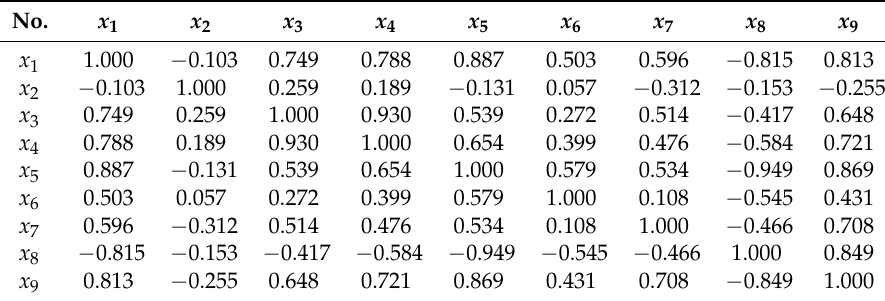
Figure 2. Scree plot. Table 3. Correlation coefficient matrix.